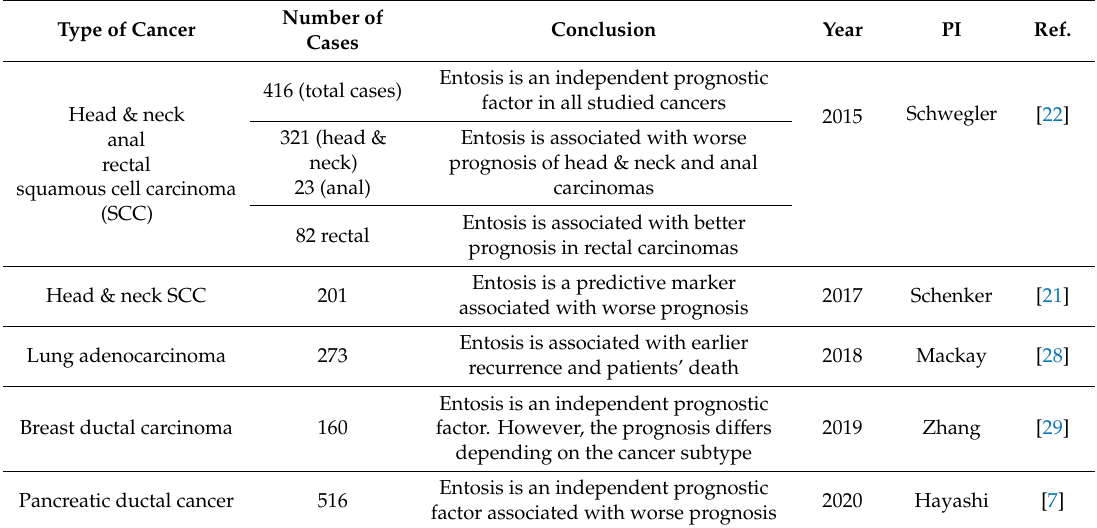
Table 1. Clinico-histopathological studies of entosis in human